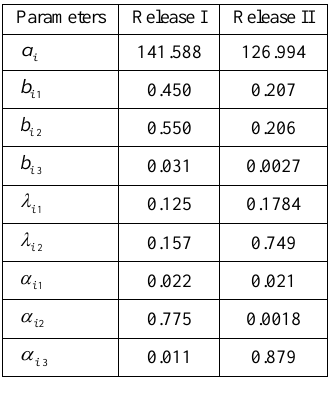
Table 1. Parameter estimation for Release I & II